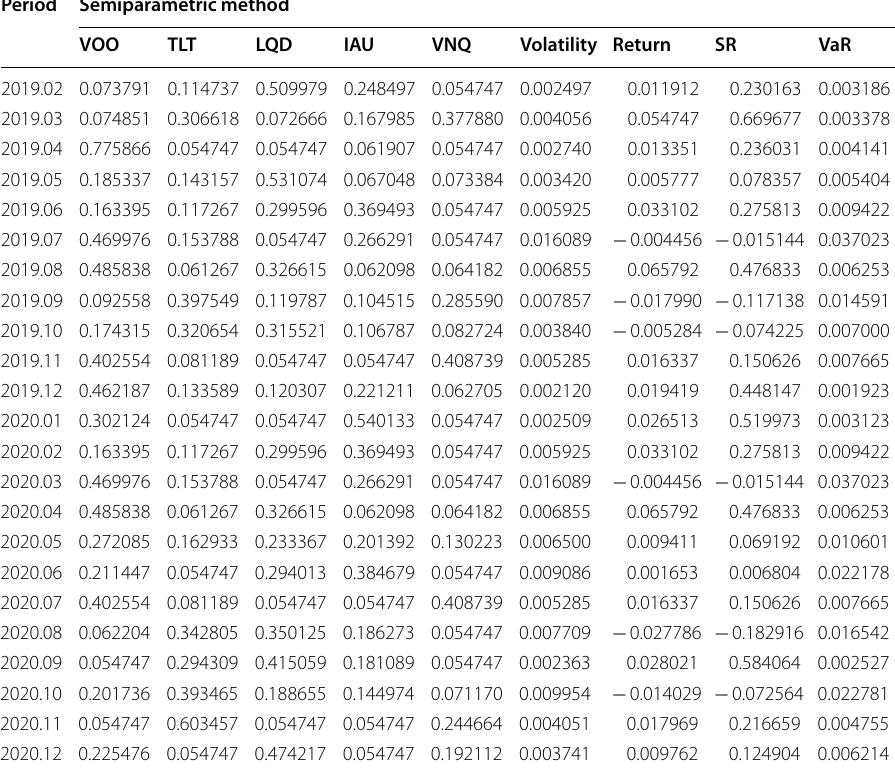
Table 5 The summary of out‑of‑sample results for Markowitz model and semiparametric method 0.05 with VaR ( α =